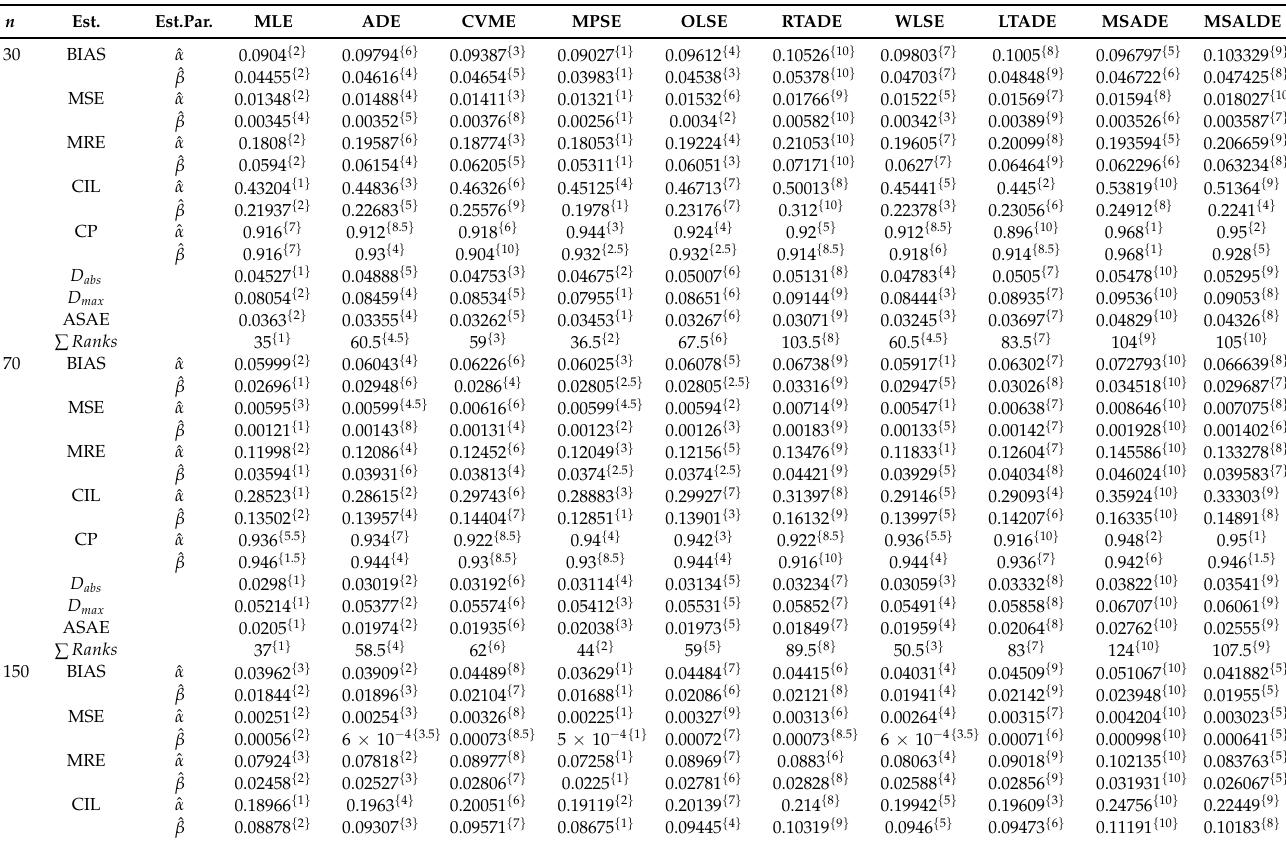
Table 1. Numerical values of PHD simulation for ( α = 0.5, β = 0.75 )